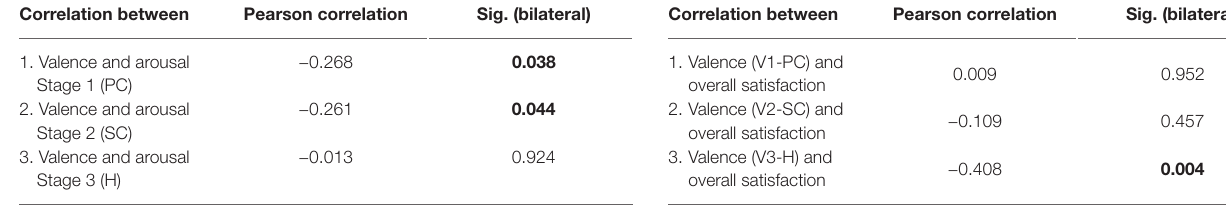
TABLE 3 | Correlations between valence (SAM) and overall satisfaction. Correlation between Pearson correlation Sig.